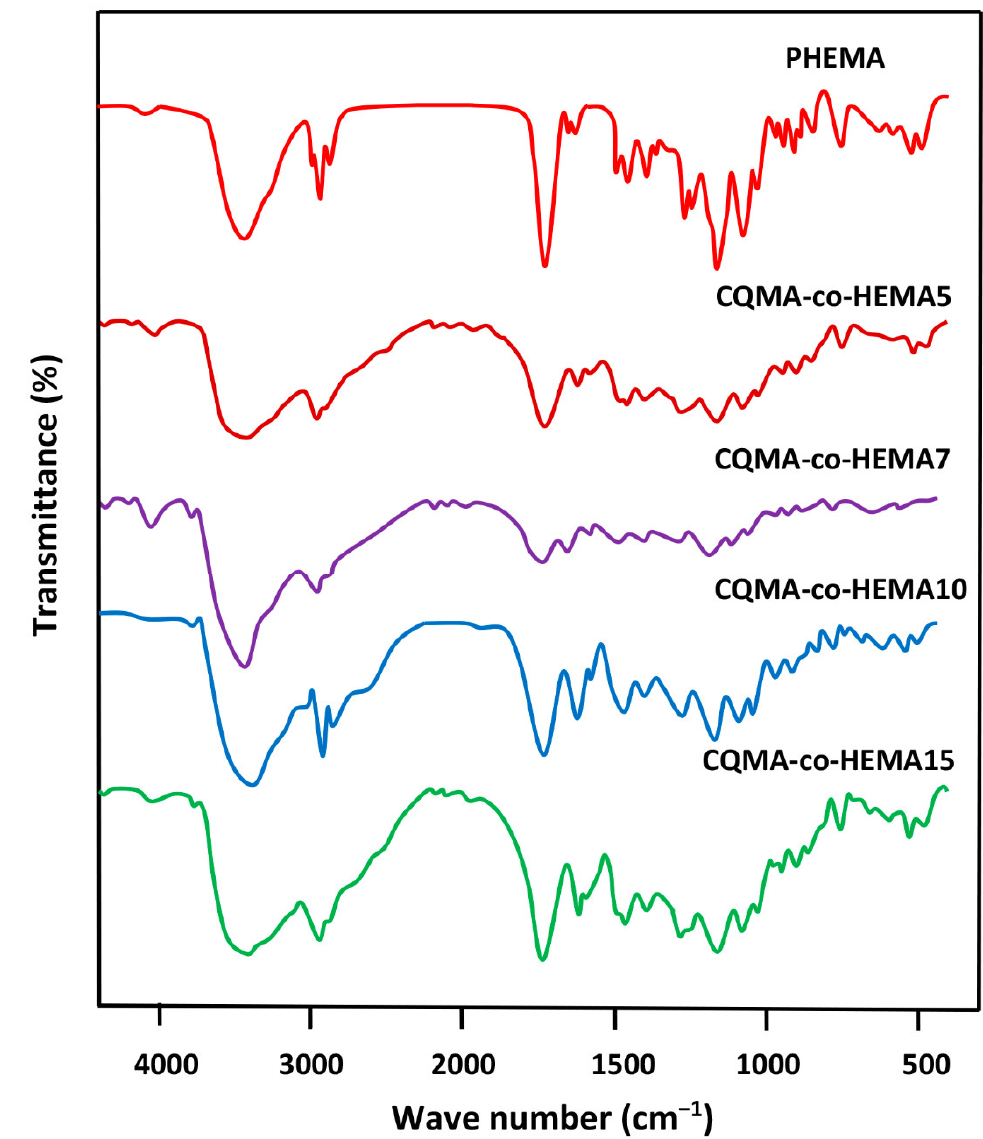
Figure 2. FTIR spectra of pure PHEMA, PCQMA and CQMA-co-HEMA